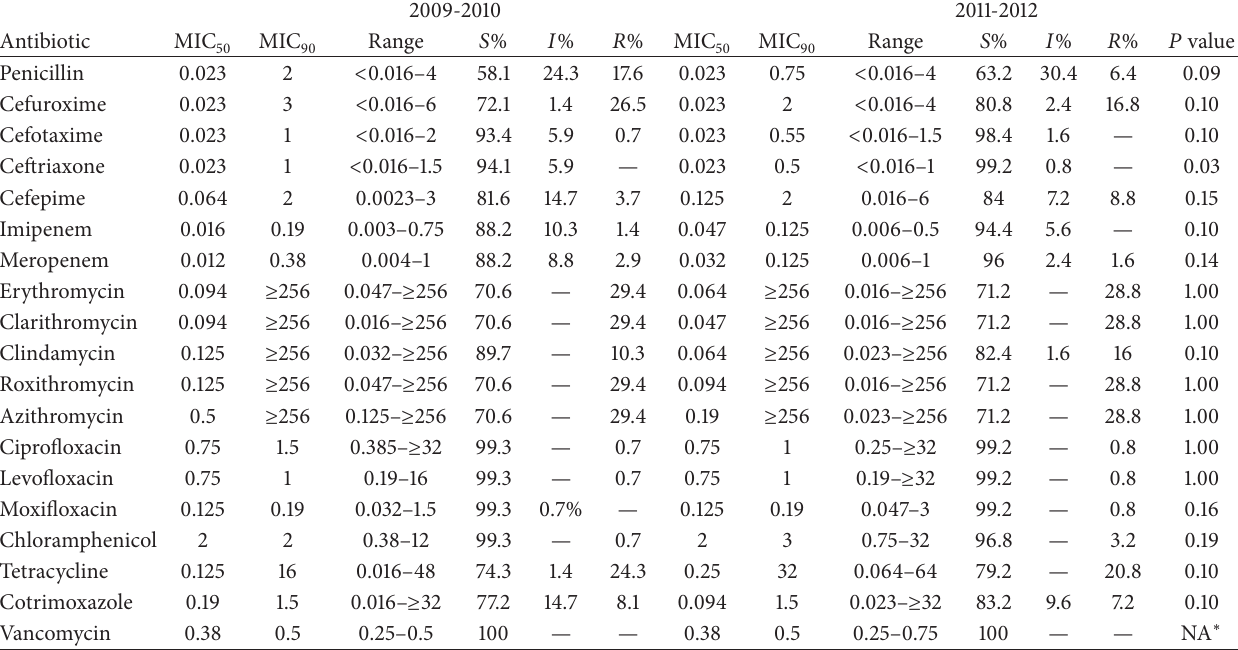
Table 3: Comparison of antibiotic resistance rates in S. pneumonia isolates over the periods 2009-2010 and 2011-2012.